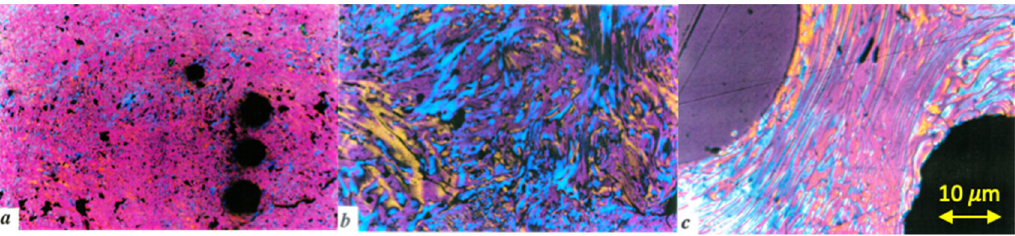
Figure 2. Optical photomicrographs of coke structures. ( a ) Mosaic, ( b ) domains, and ( c ) flow domains.